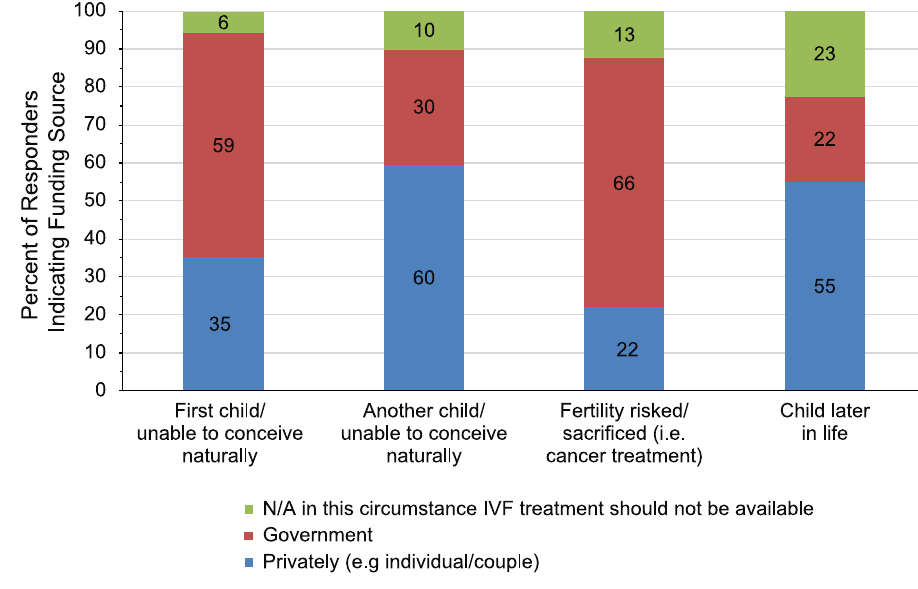
Fig 3. Opinions regarding the funding source for IVF. See questionnaire for full response text.